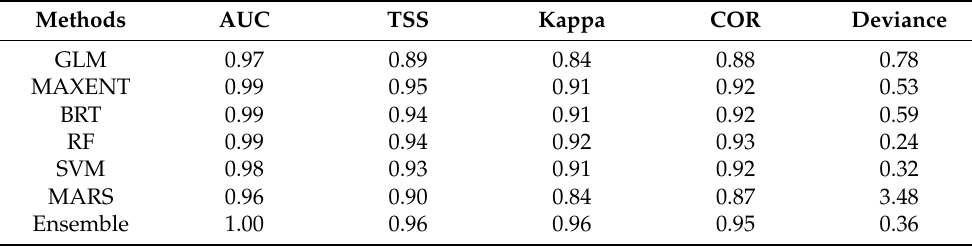
Table 2. Performance evaluation of SDMs using different statistical